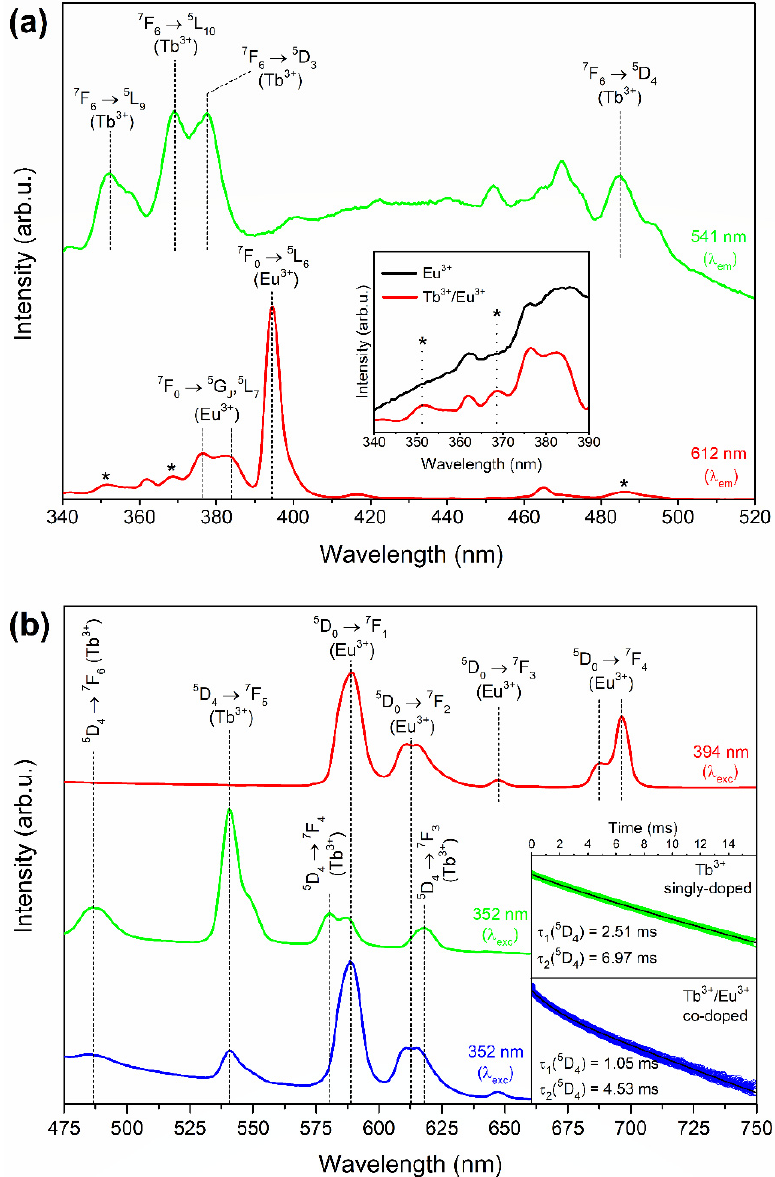
Figure 6. The excitation spectra recorded for Tb 3+ ( λ em = 541 nm) and Eu 3+ ( λ em = 612 nm) ions in prepared SiO 2 -BaF 2 nano-glass-ceramics. For the latter, the additional lines originated from Tb 3+ ions were marked by asterisks ( a ). The registered emission spectra for nGC Tb (green line, λ exc = 352 nm) as well as nGC Tb/Eu glass-ceramics (blue line, λ exc = 352 nm; red line, λ exc = 394 nm). Inset shows the decay curves recorded for the 5 D 4 (Tb 3+ ) state in nano-glass-ceramics ( b ). The emission spectrum of the nGC Tb/Eu sample, collected upon 352 nm excitation, revealed an intense orange (589 nm) and red (611 nm/615 nm, and 647 nm) luminescence corresponding to the transitions of Eu 3+ from the 5 D 0 level. Along with those bands, two emission lines with relatively low intensity were found within the blue–green scope and were assigned to the emissions originating from the 5 D 4 state of Tb 3+ ions. Therefore, com- pared with XG Tb/Eu , the luminescence in the reddish-orange spectral range is